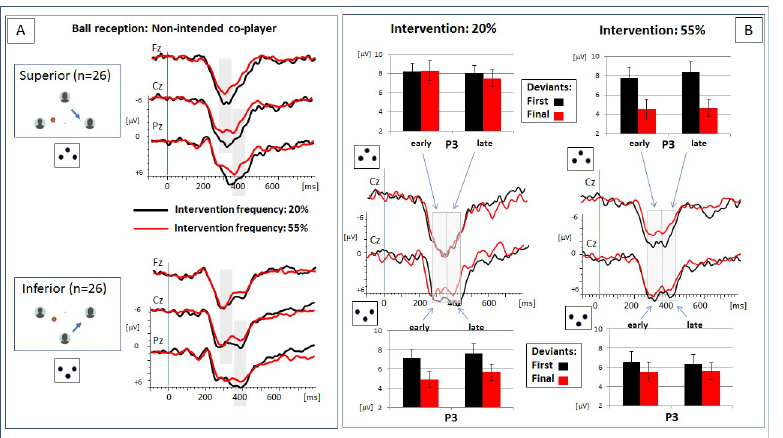
Fig 3. Effect of verticality on the processing of the deviant event (non-intended outcome): (A) ERP effect of intervention frequency separated for the vertical position of the participants’ avatar: At superior position, the P3 amplitude effect is clearly expressed for the fronto-central P3a and centro-parietal P3b amplitude. At inferior position, effects are reduced and restricted to the centro-parietal P3b amplitude. (B) ERP response at electrode Cz to the first and final deviants within an experimental block. Effects are separated for the intervention frequency (20%: left column vs. 55%: right column) and vertical position of the avatar (superior: upper row vs. inferior: lower row). If intervention frequency is low (20%), P3 responses to the final deviants is significantly reduced at an inferior position but remains stable at a superior position. If intervention frequency is high (55%), the response to the final deviants is markedly reduced–independently of the vertical